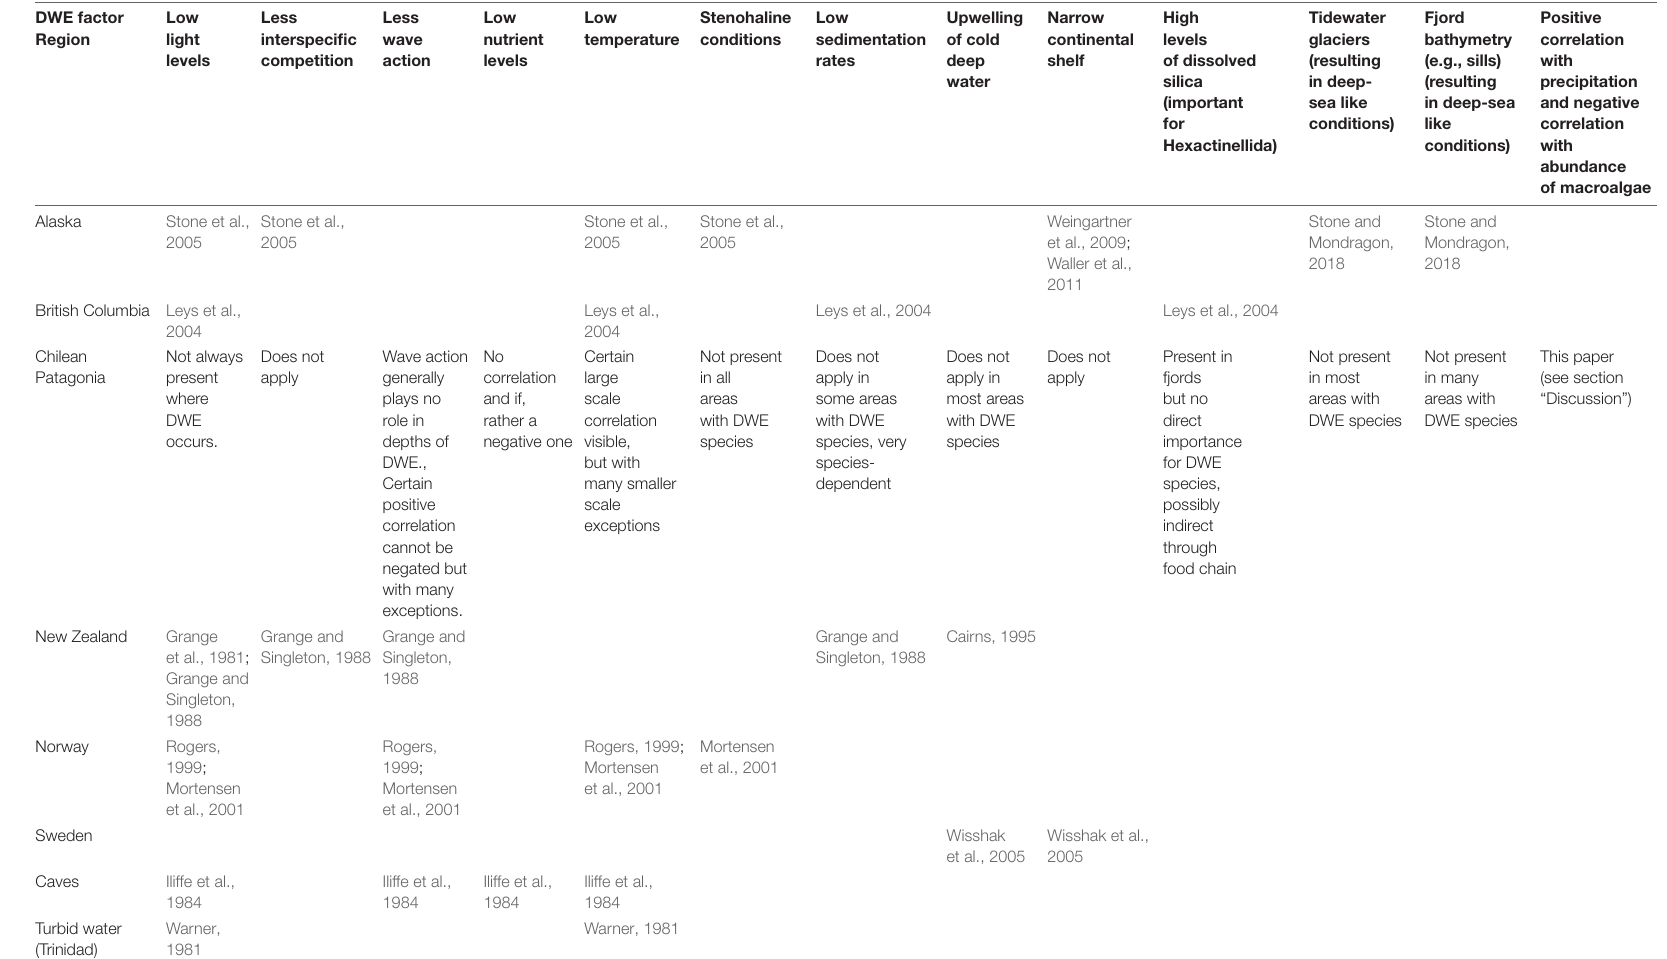
TABLE 4 | Literature overview on deep-water emergence theories from different regions: North America (Alaska and British Columbia), Chilean Patagonia, New Zealand, Scandinavia (Norway, Sweden), caves and turbid waters (Trinidad). DWE factor